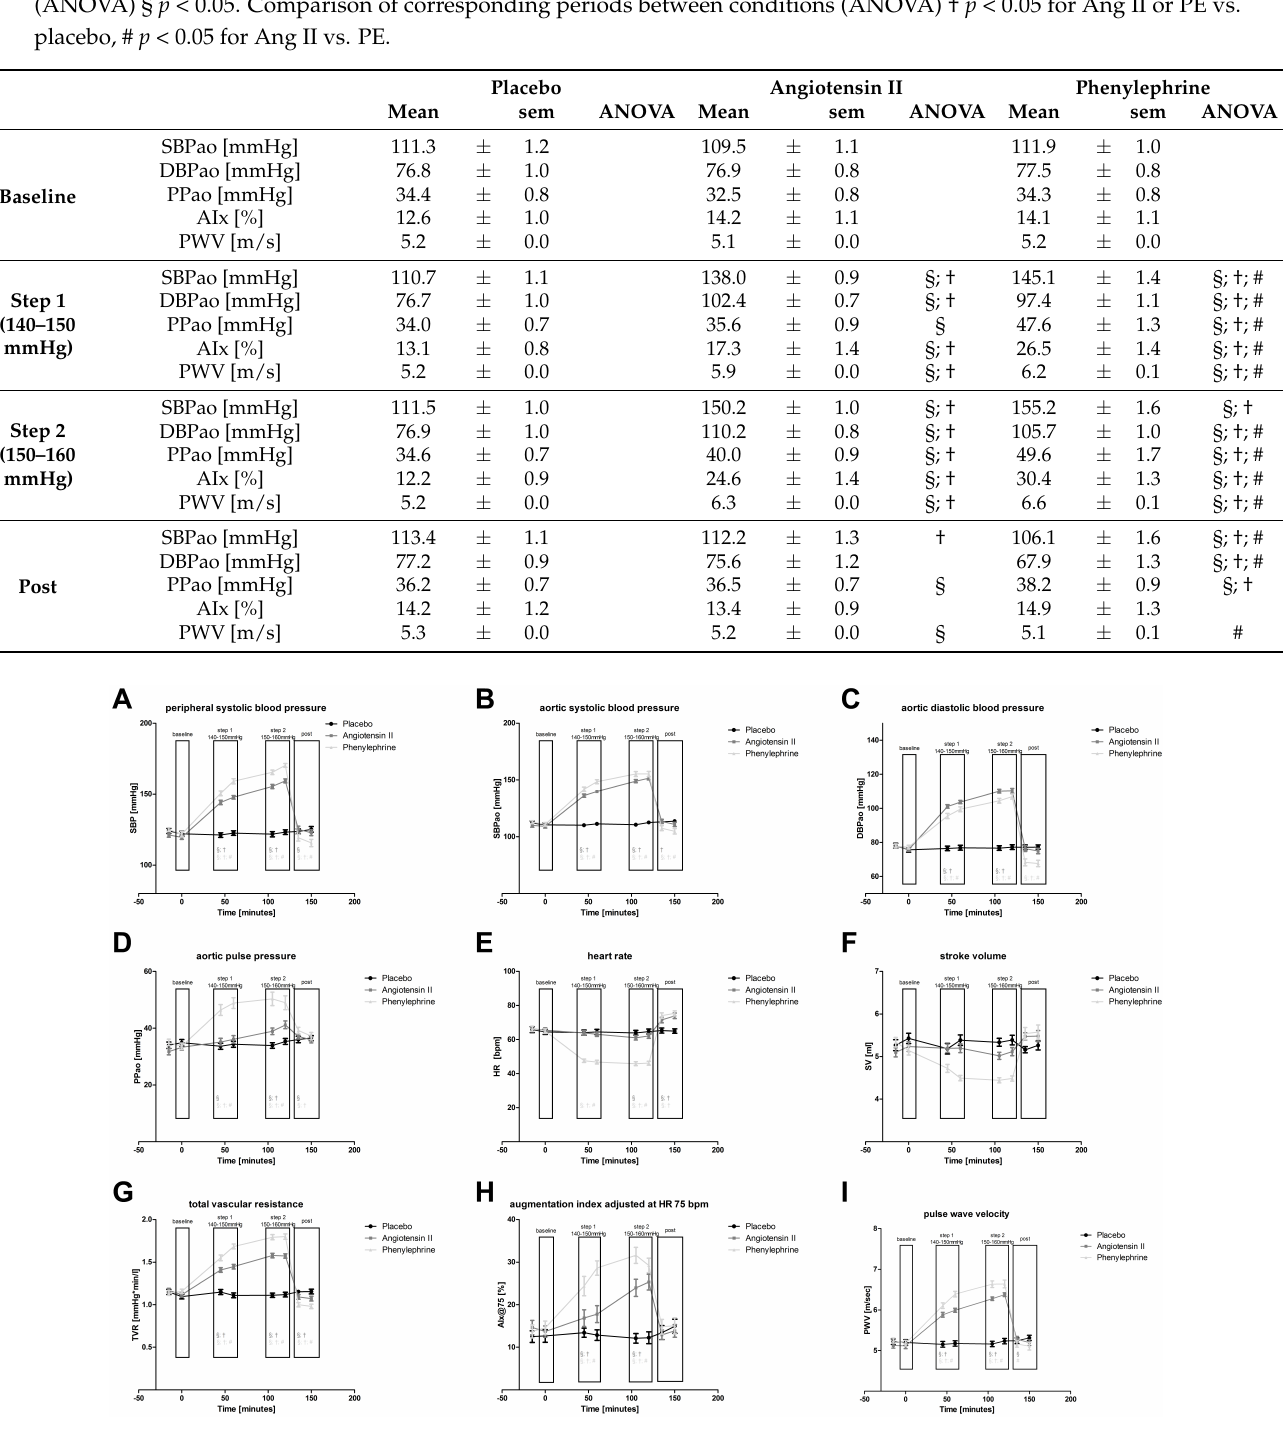
Figure 2. Hemodynamic parameters and arterial stiffness throughout the experiments consisting of baseline, infusion step Figure 1. CPAP device for treating OSA. 1, step 2 and post-infusion period. ( a ) peripheral systolic blood pressure (SBP), ( b ) aortic systolic blood pressure (SBPao), ( c ) aortic diastolic blood pressure (DBPao), ( d ) aortic pulse pressure (PPao), ( e ) heart rate (HR), ( f ) stroke volume (SV), ( g ) total vascular resistance (TVR), ( h ) augmentation index at HR 75 bpm (AIx), ( i ) pulse wave-velocity (PWV). Values are expressed as means ± standard error of mean (SEM). Ang II (dark grey) or PE (light grey) vs. placebo (black). Comparison of different periods within condition (ANOVA) § p < 0.05. Comparison of corresponding periods between conditions (ANOVA) † p < 0.05 for Ang II or PE vs. placebo, # p < 0.05 for Ang II vs.